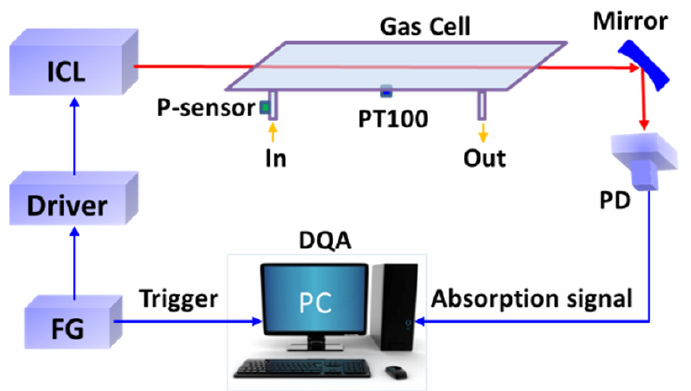
Figure 1. Experimental setup of the spectrometer for measuring the pressure broadening coefficients, P-sensor: pressure sensor; PD: photodetector; FG: function generator; DAQ: data acquisition card.